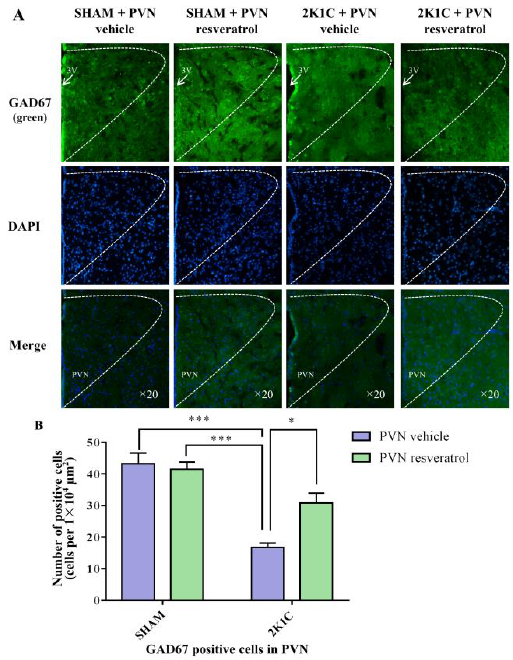
Figure 8. The effects of PVN resveratrol on GAD67 expression. ( A ) Immunofluorescence staining of